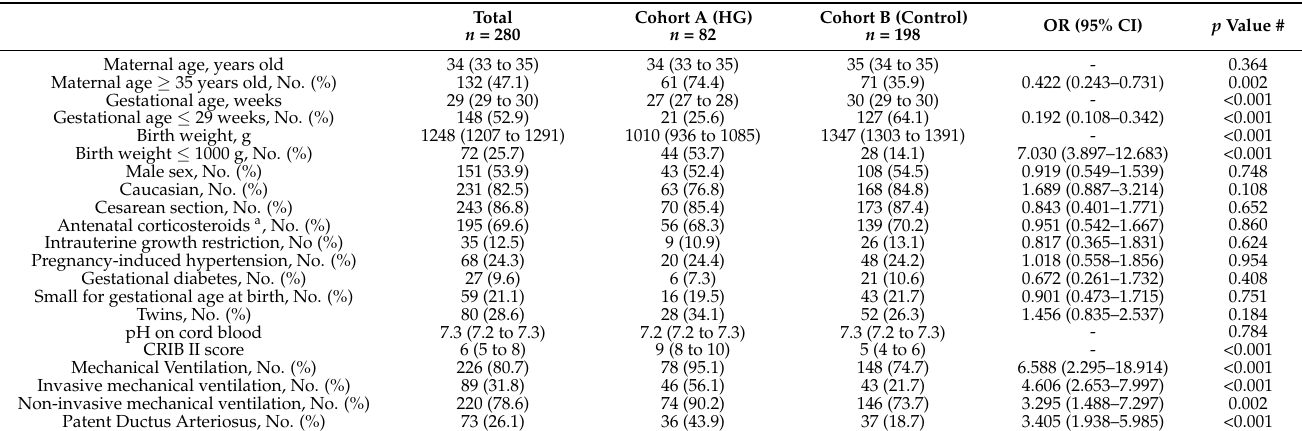
Figure 1. Flow chart. Figure legend: HG (hyperglycemia). Table 1. Baseline clinical characteristics of the study population.